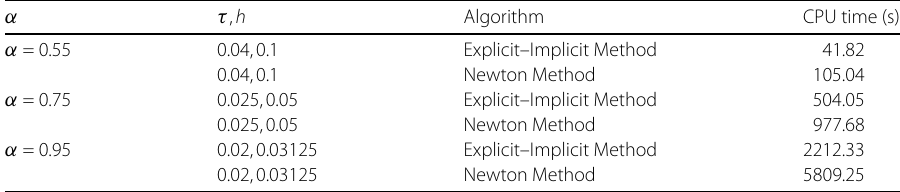
Table 4 The time costs of Explicit–Implicit Method and Newton Method when T = 2 α τ , h Algorithm CPU time (s) α =